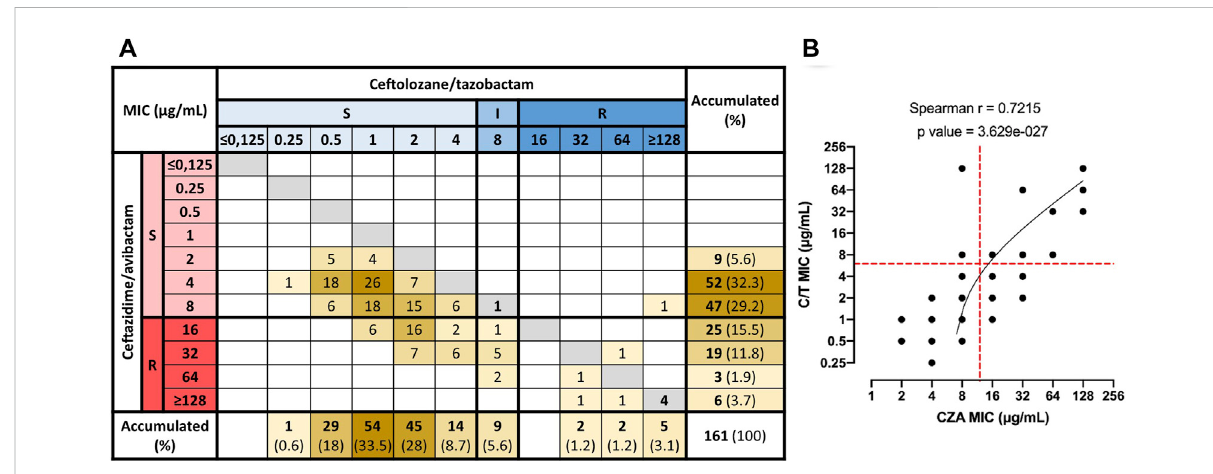
FIGURE 2 CorrelationbetweenMICvaluesofCZAandC/TinNon-CP-CRPAclinicalisolates.CombinationsofCZAandC/TMICvaluesforeachoneofthe Non-CP-CRPA isolates werequanti fi edand represented inamatrix (A) . MICvaluesweregrouped as S(susceptible), I (intermediate), andR(resistant) according to the breakpoint of CZA and C/T established by CLSI (2020). (B) The correlation analysis (Spearman ’ s rank correlation test) showed that theMIC distribution ofCZA and C/T presented a signi fi cant positive correlation (Spearman r: 0.7215; p < 0.0001). However, most ofthe isolates (95.7%) had lower C/T MIC values than those obtained for CZA, indicating that C/T presented a higher activity than CZA overall Non-CP-CRPA isolates. Furthermore, most CZA-resistant isolates remained susceptible to C/T, but most C/T-resistant isolates also showed a CZA-resistant